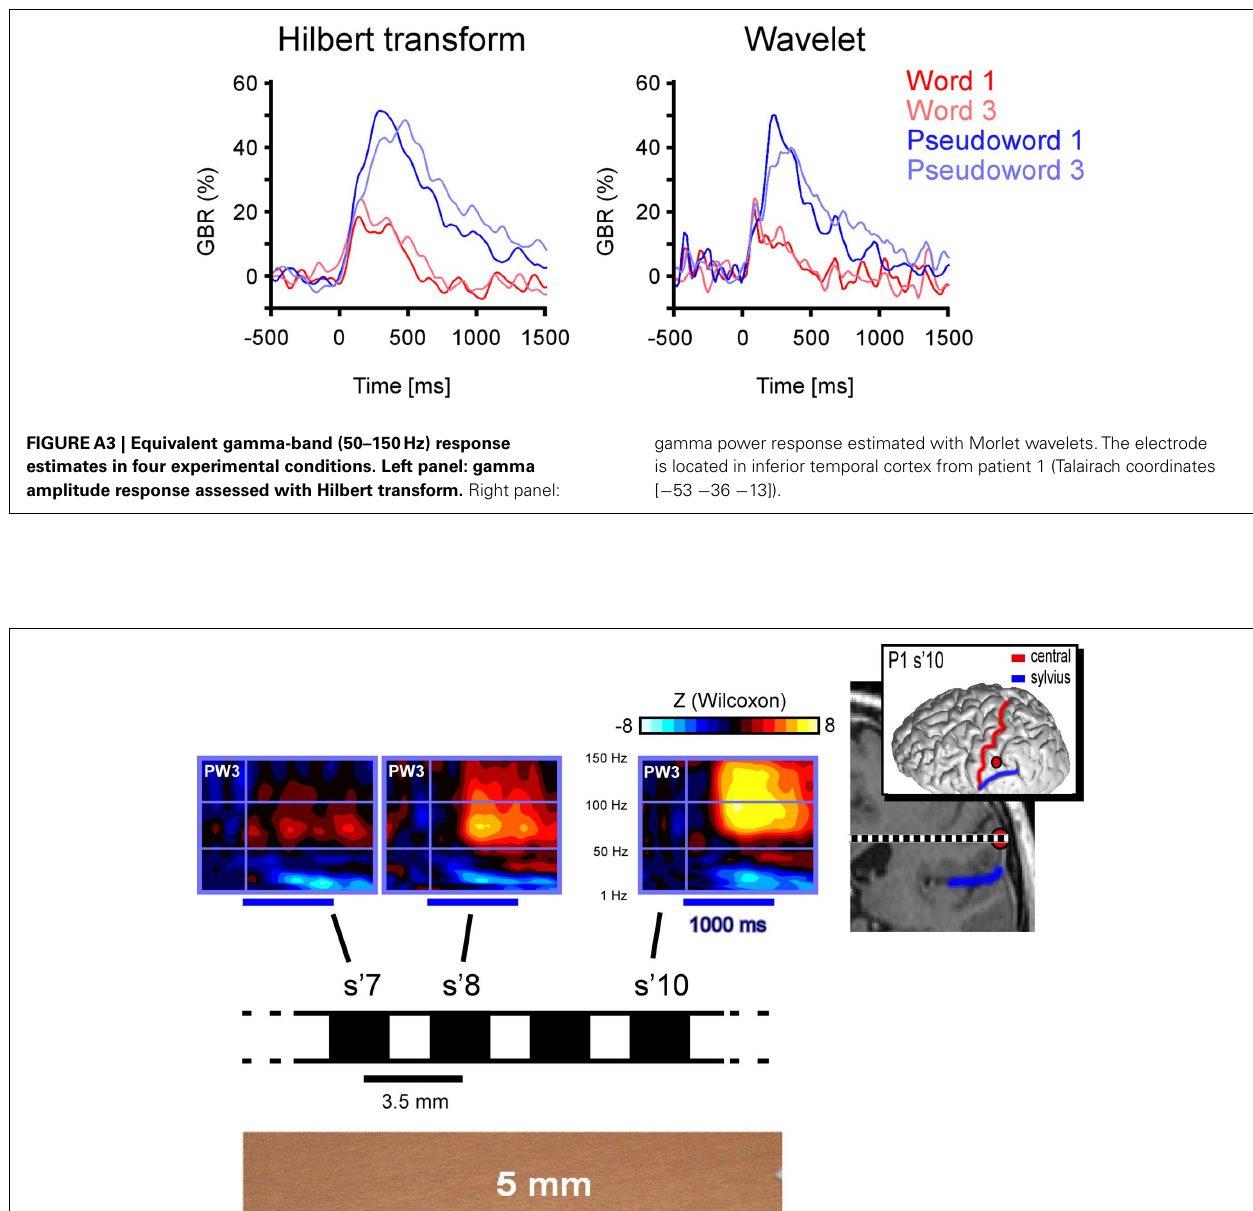
FIGUREA4 | Example of spatial precision and functional neural responses. Upper left panel. On electrode “s (cid:2) ” the GBR to pseudo-word 3 increases progressively from medial (s (cid:2) 7) to lateral (s (cid:2) 10) recording sites. Upper right panel.The MNI brain of the patient